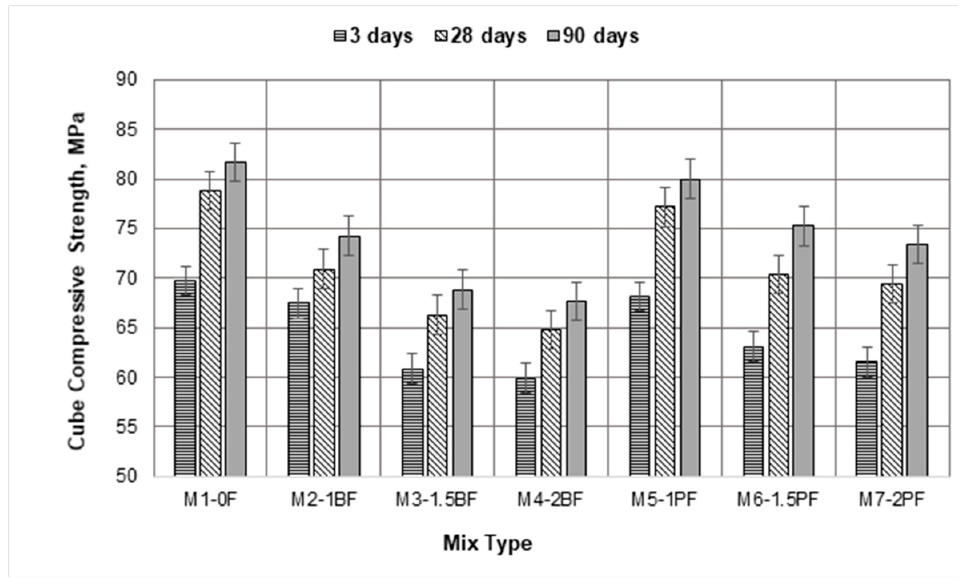
Figure 10. Concrete cube compressive strength measured at 3, 28, and 90 days.